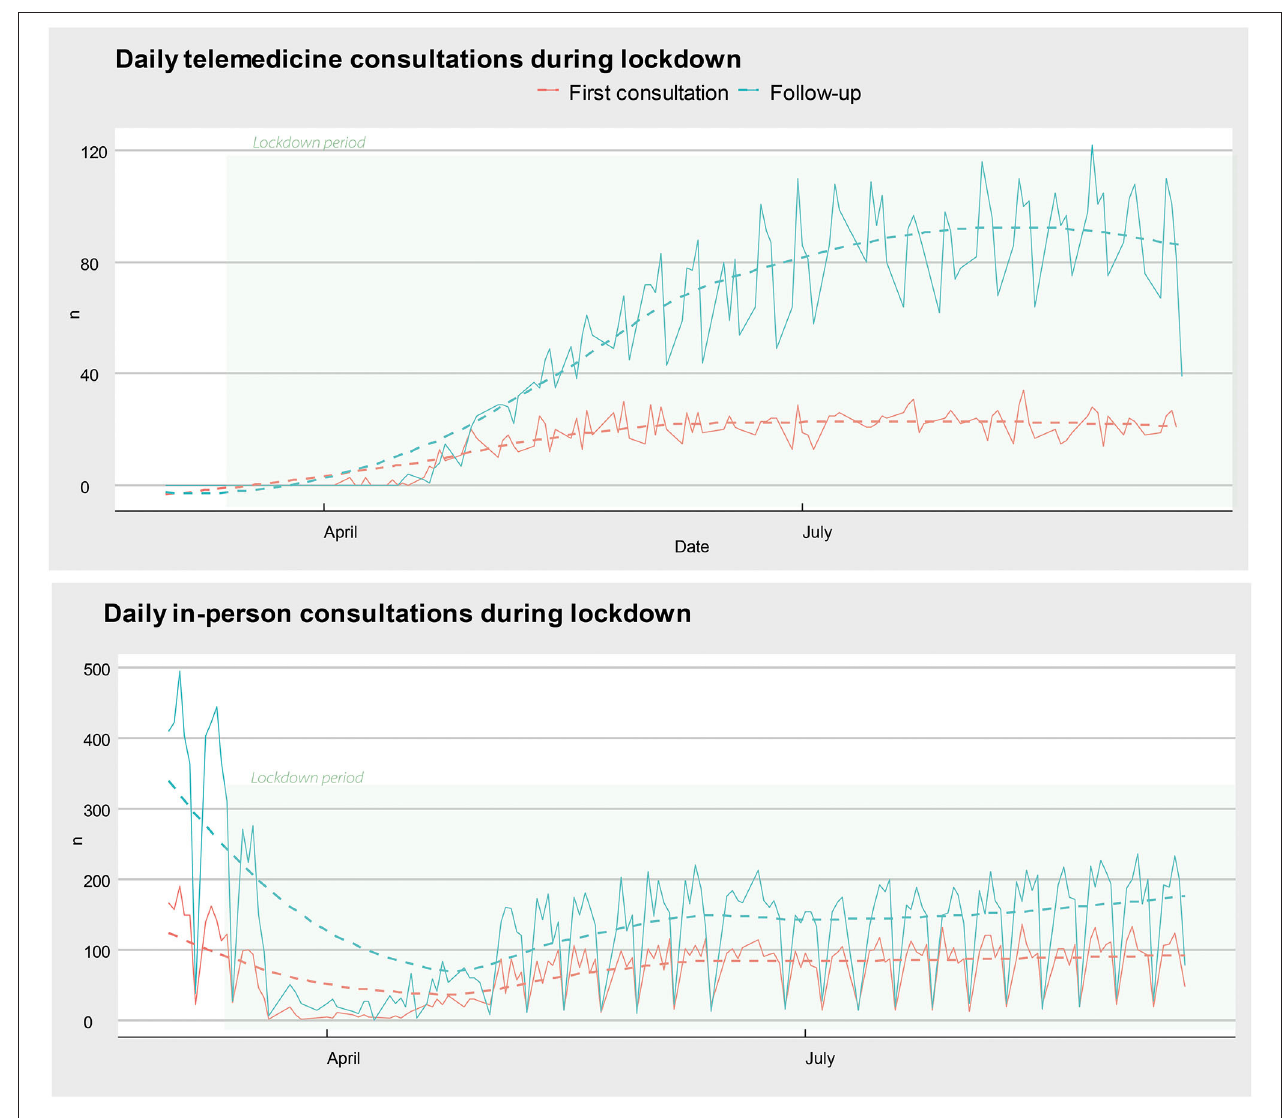
FIGURE 2 | Evolution of telemedicine and in-person consults during the lockdown. The number of first-time (red) and follow-up (blue) visits over time. The dashed lines represent the time trend in a general linear model. Of note, telemedicine visits increase in early April, shortly after the beginning of the lockdown mandate (March 20).